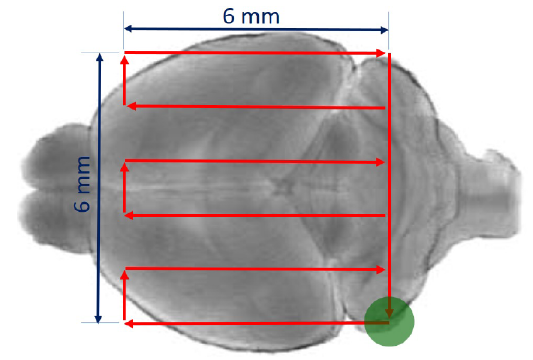
Figure 1. Scanning trajectory (in red) over the mouse brain.